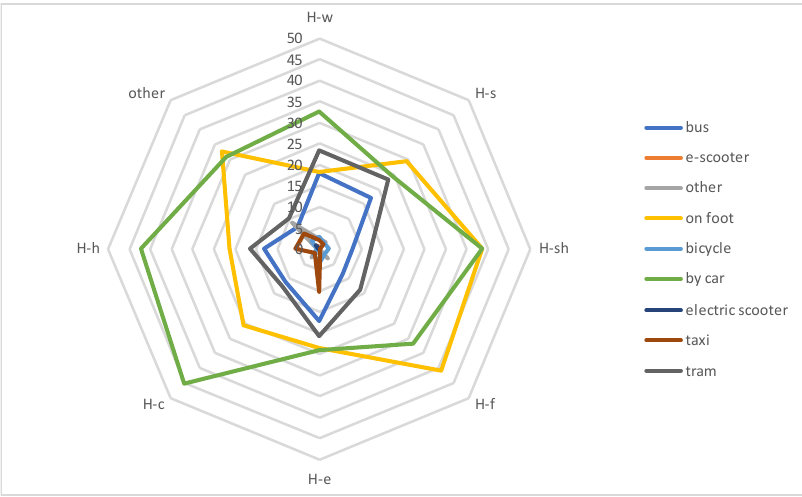
Figure 3. Selection of the means of transport depending on the direction of travel. Most directions are dominated by car. In the H-f, H-s, and o directions, the pedestrian form of transport dominates. In the H-sh and H-e directions, car and on-foot transporta- tion are chosen equally often. The respondents’ choices may indicate certain customary behaviors, e.g., car transport is favored for weekly shopping because it increases comfort and accessibility to shopping centers. Similar results are seen in the case of leisure travel; however, respondents most often used cars, but in the form of a taxi. On the basis of the multi-way tables and interaction charts, it was possible to infer the individual means of transport most often chosen by users in the home–work